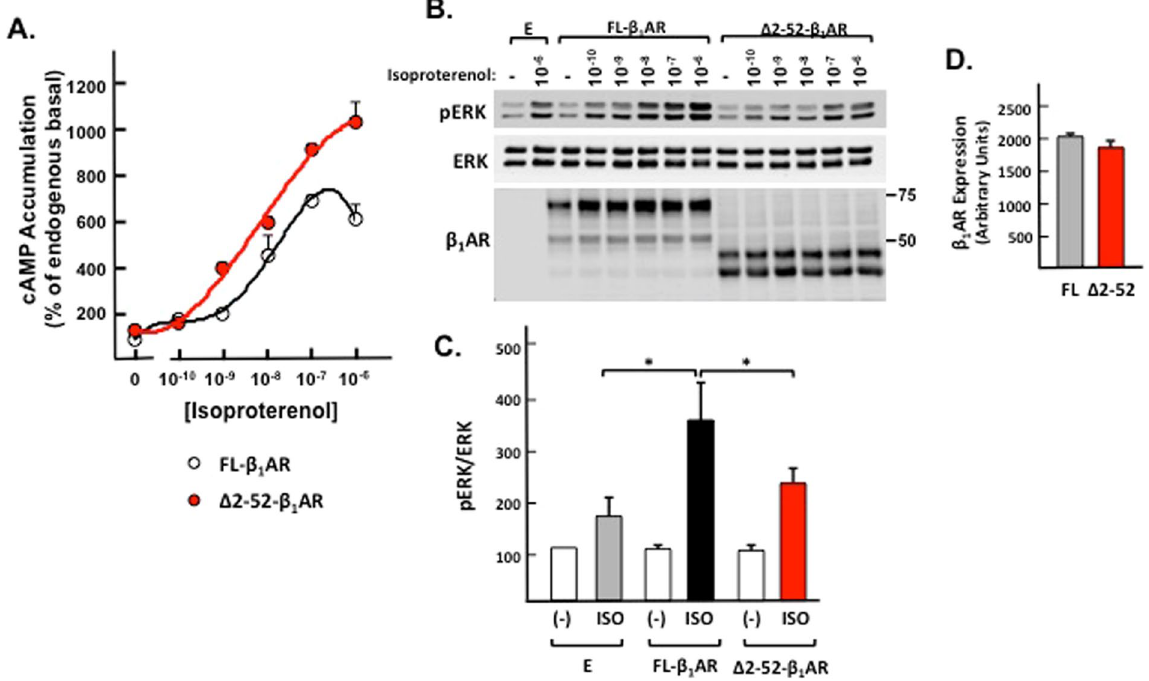
Figure 6. N-terminal truncation influences β 1 AR signaling to cAMP versus ERK pathways in cardiomyocytes. Neonatal cardiomyocyte cultures were infected with empty vector (E) or adenoviruses that drive expression of FL (Ad-FL- β 1 AR) or truncated (Ad- ∆ 2-52- β 1 AR) forms of the β 1 AR. Panel A : Cultures were preincubated with 10 mM theophylline for 1 h at 37 °C and then challenged with vehicle or a range of isoproterenol concentrations and cAMP accumulation was measured according to Methods. Analysis by ANOVA followed by Tukey’s test showed that maximal cAMP accumulation is higher in Ad- ∆ 2-52- β 1 AR than in Ad-FL- β 1 AR cultures (p < 0.05, n = 3). Panel B: Lysates from cultures treated for 5 min with vehicle or a range of isoproterenol concentrations were subjected to immunoblot analysis for ERK protein and phosphorylation and β 1 AR protein expression. Panel C: Quantification of pERK (normalized to ERK protein) in resting and 10 − 6 M isoproterenol-treated cultures infected with empty vector, FL- β 1 AR or ∆ 2-52- β 1 AR showing that basal pERK/ ERK ratios are not influenced by Ad-FL- β 1 AR or Ad- ∆ 2-52- β 1 AR overexpression, but Isoproterenol-dependent ERK phosphorylation is higher in Ad-FL- β 1 AR than in Ad- ∆ 2-52- β 1 AR cultures (mean ± SEM, n = 6, * p < 0.05). Panel D: FL- β 1 AR and ∆ 2-52- β 1 AR expression was quantified (by combining signals from the two immunoreactive species detected for each construct) and did not differ (mean ± SEM, n = 6,